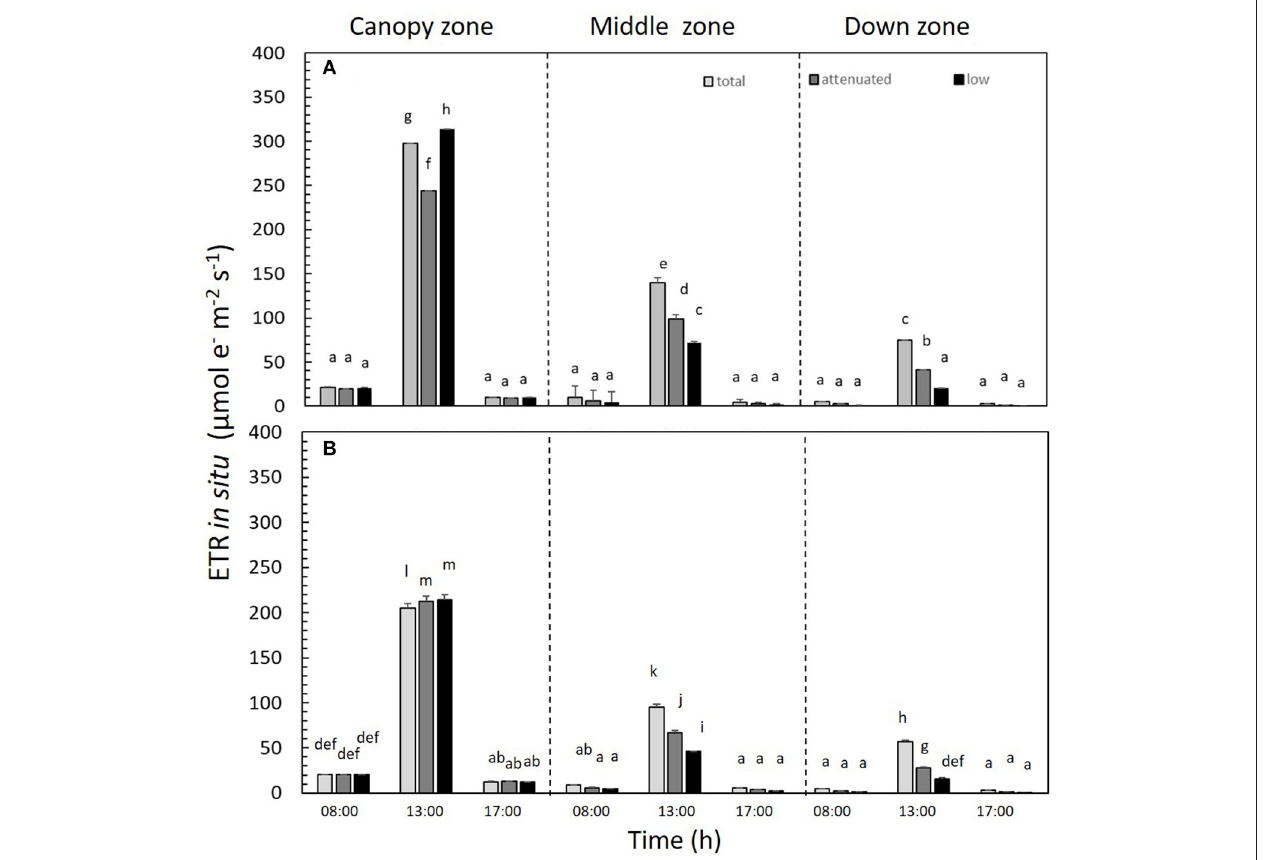
FIGURE 5 | In situ electron transport rate (ETR in situ ) in Macrocystis pyrifera fronds in the (A) first daily cycle experiment and (B) second daily cycle experiment under different solar irradiance treatments: total, attenuated, and low radiation at 8:00, 13:00, and 17:00h. The ETR in situ was measured in three zones of the alga: canopy, middle, and down (mean ± SE, n = 3). Lower-case letters denote significant differences after the SNK